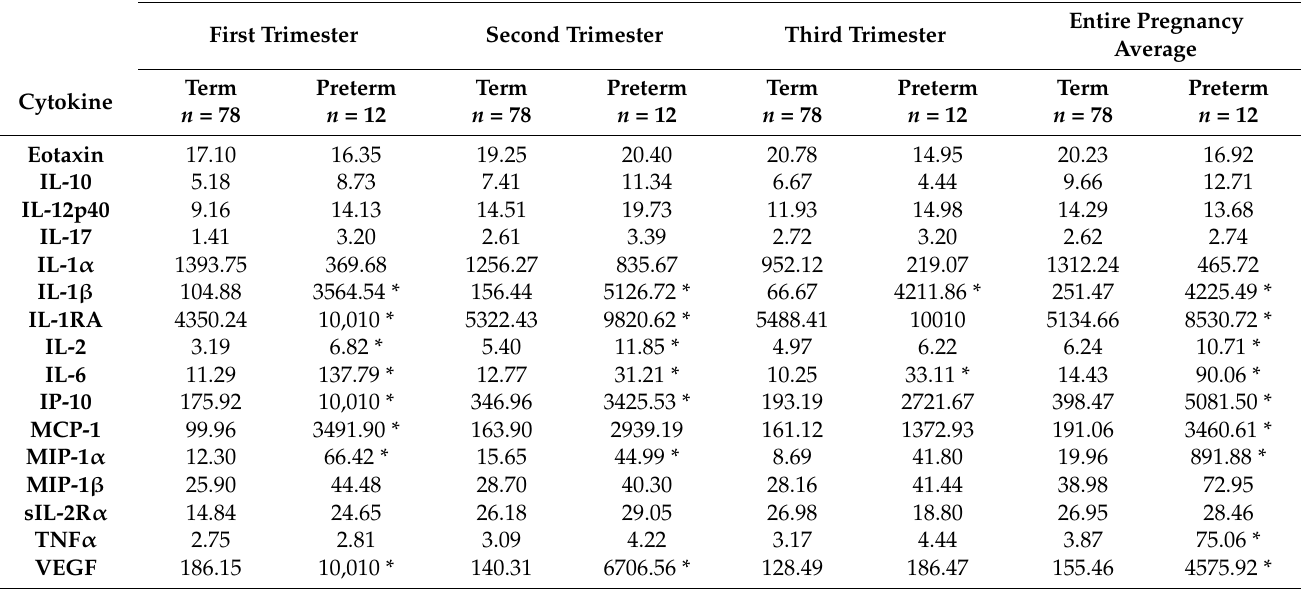
Table 2. Median cytokine concentrations (pg/mL) by preterm birth status for the first, second and third trimesters and entire pregnancy average from the PRINCESA Cohort in Mexico City, 2009-14 (N =